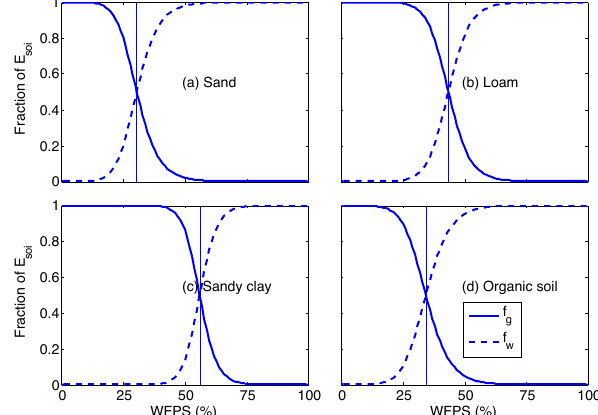
Fig. 5. Partitioning of evaporation into direct liquid water vapor- Figure 5. Partitioning of evaporation into direct liquid water vaporization and water 2 ization and water vapor transport from below the soil surface for vapor transport from below the soil surface for the four soils listed in Table 3. For all 3 the four soils listed in Table 3. For all cases, we assumed D 0 = =˙1.75cm (as it is used in " 5 m 2 s -1 and ! z cases, we assumed D cm (as it is used in CLM4). 4 2 . 4 × 10 − 5 m 2 s − 1 and 1 z 1 = 1.75 0 = 2.4 ! 10 1